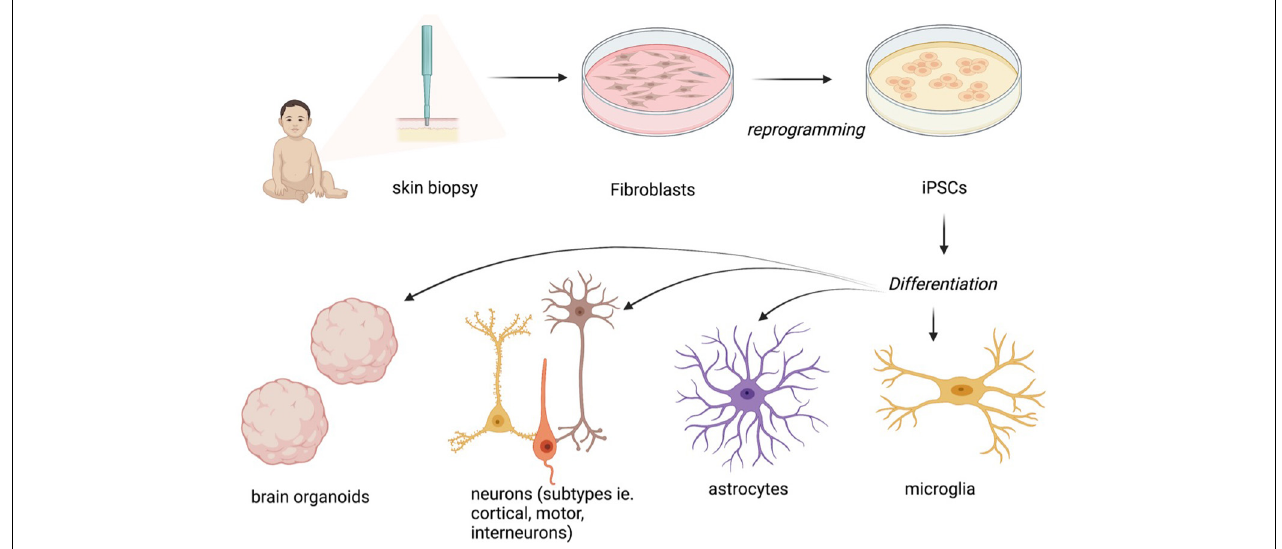
FIGURE 1 | Normal MeCP2 function as a transcriptional repressor and activator and consequences of abnormal MeCP2 function in the brain at a cellular level. “Created with